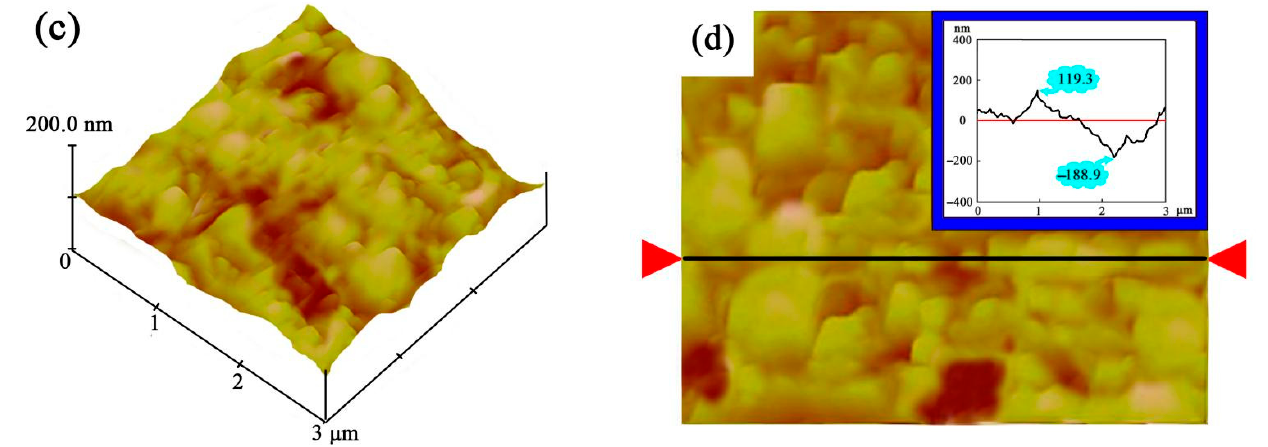
Figure 4. AFM pictures of three dimensional morphologies: ( a ) S2 and ( c ) S4 nanocomposites; AFM pictures of two dimensional morphologies: ( b ) S2 and ( d ) S4 nanocomposites.